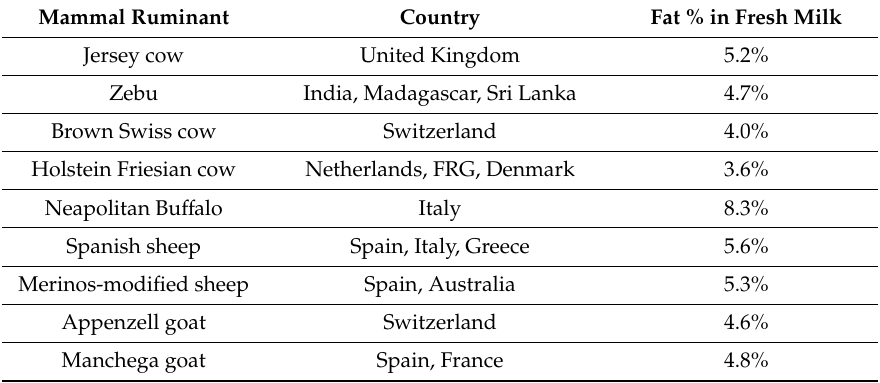
Table 2. Average fat matter percent in fresh milk of some mammal